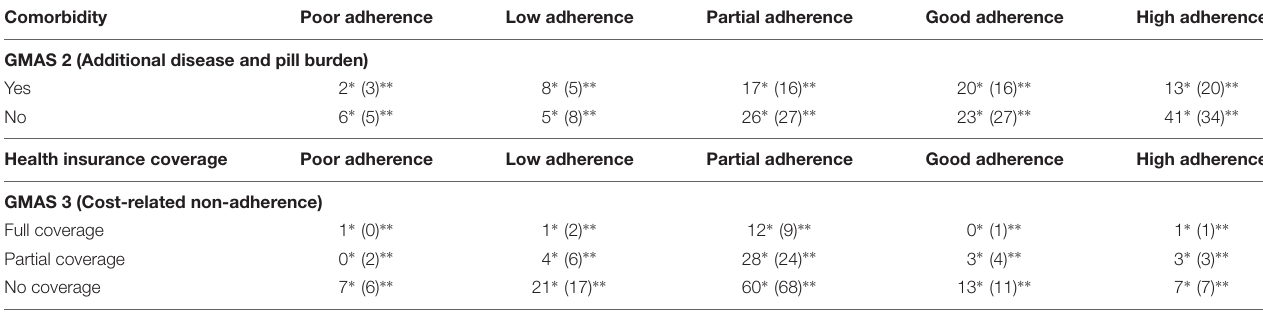
TABLE 4 | Cross tabulation between patient groups and adherence scores. Comorbidity Poor